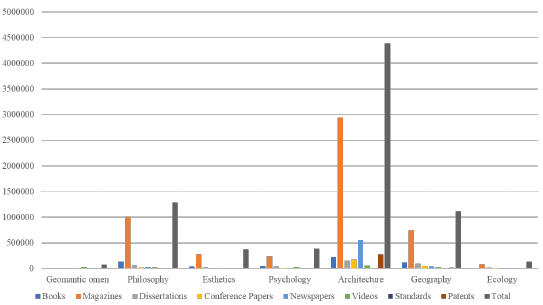
Table 3. Statistical tables for geomantic omen and other disciplines